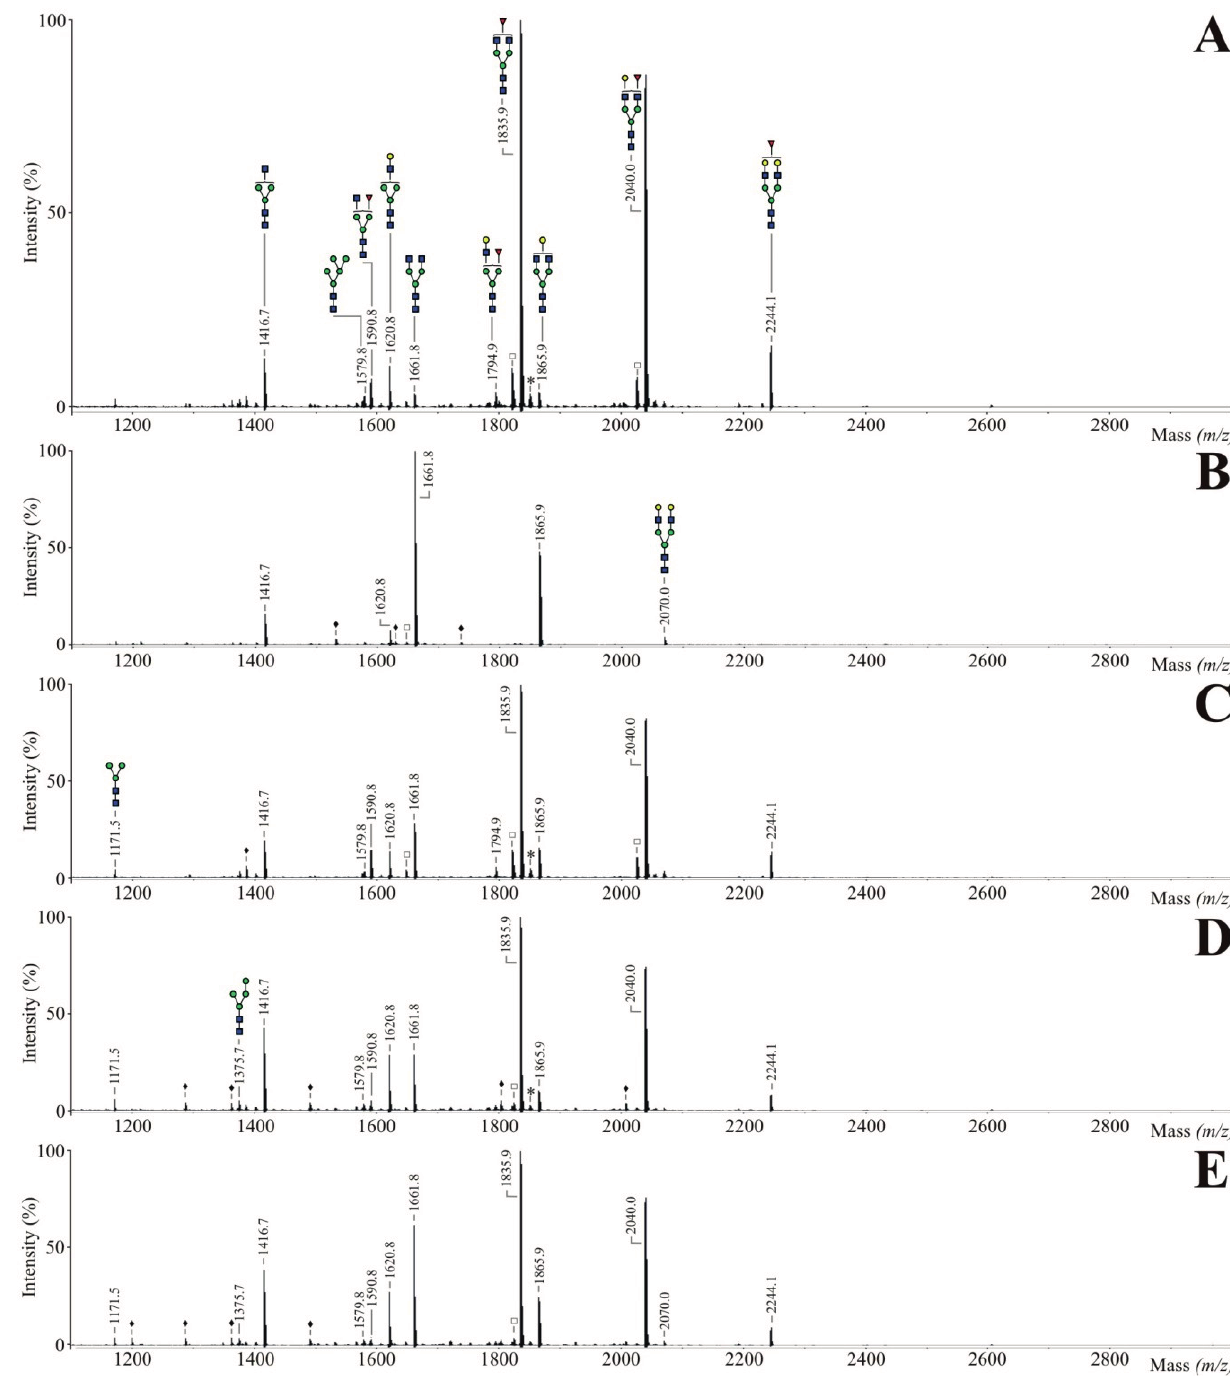
Figure 5. MALDI-TOF mass spectra of permethylated N- glycans of purified trastuzumab after three-day treatment of CHO RMD cells with 80 µM of Ac 4 Fuc ( C ), Prop 4 Fuc ( D ) or PEG 4 Fuc ( E ) under serum-free culture conditions; in comparison to an untreated control of the CHO ( A ) or CHO RMD cell line ( B ). N -linked glycans were released enzymatically using N -glycosidase F. Molecular ions are present in either sodiated [M + Na] + or potassiated [M + K] + form (*). Permethylation artifacts are marked by an unfilled square ( □ ) and unidentified peaks by a black diamond ( ♦ ). All signals with relative peak areas higher than 0.5% are labeled with their respective numerical m/z -values. Graphical visualization of all structures is only done once per m/z in the whole Figure ( A – E